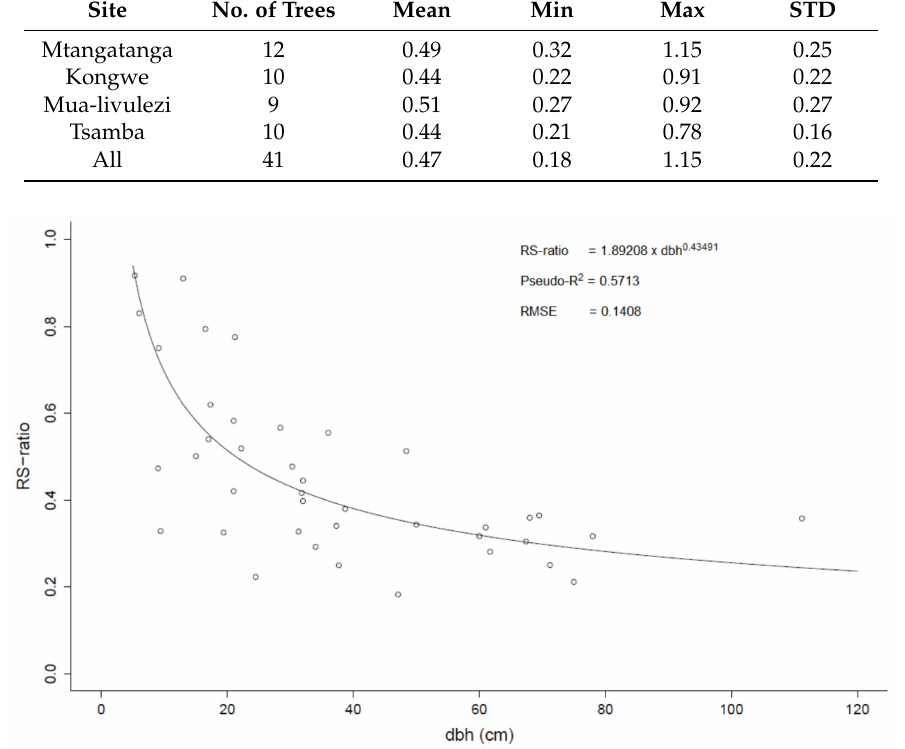
Figure 4. Root to shoot ratio (RS-ratio) vs. diameter at breast height (dbh). The dots represent observations for individual trees and the line represents the fitted nonlinear